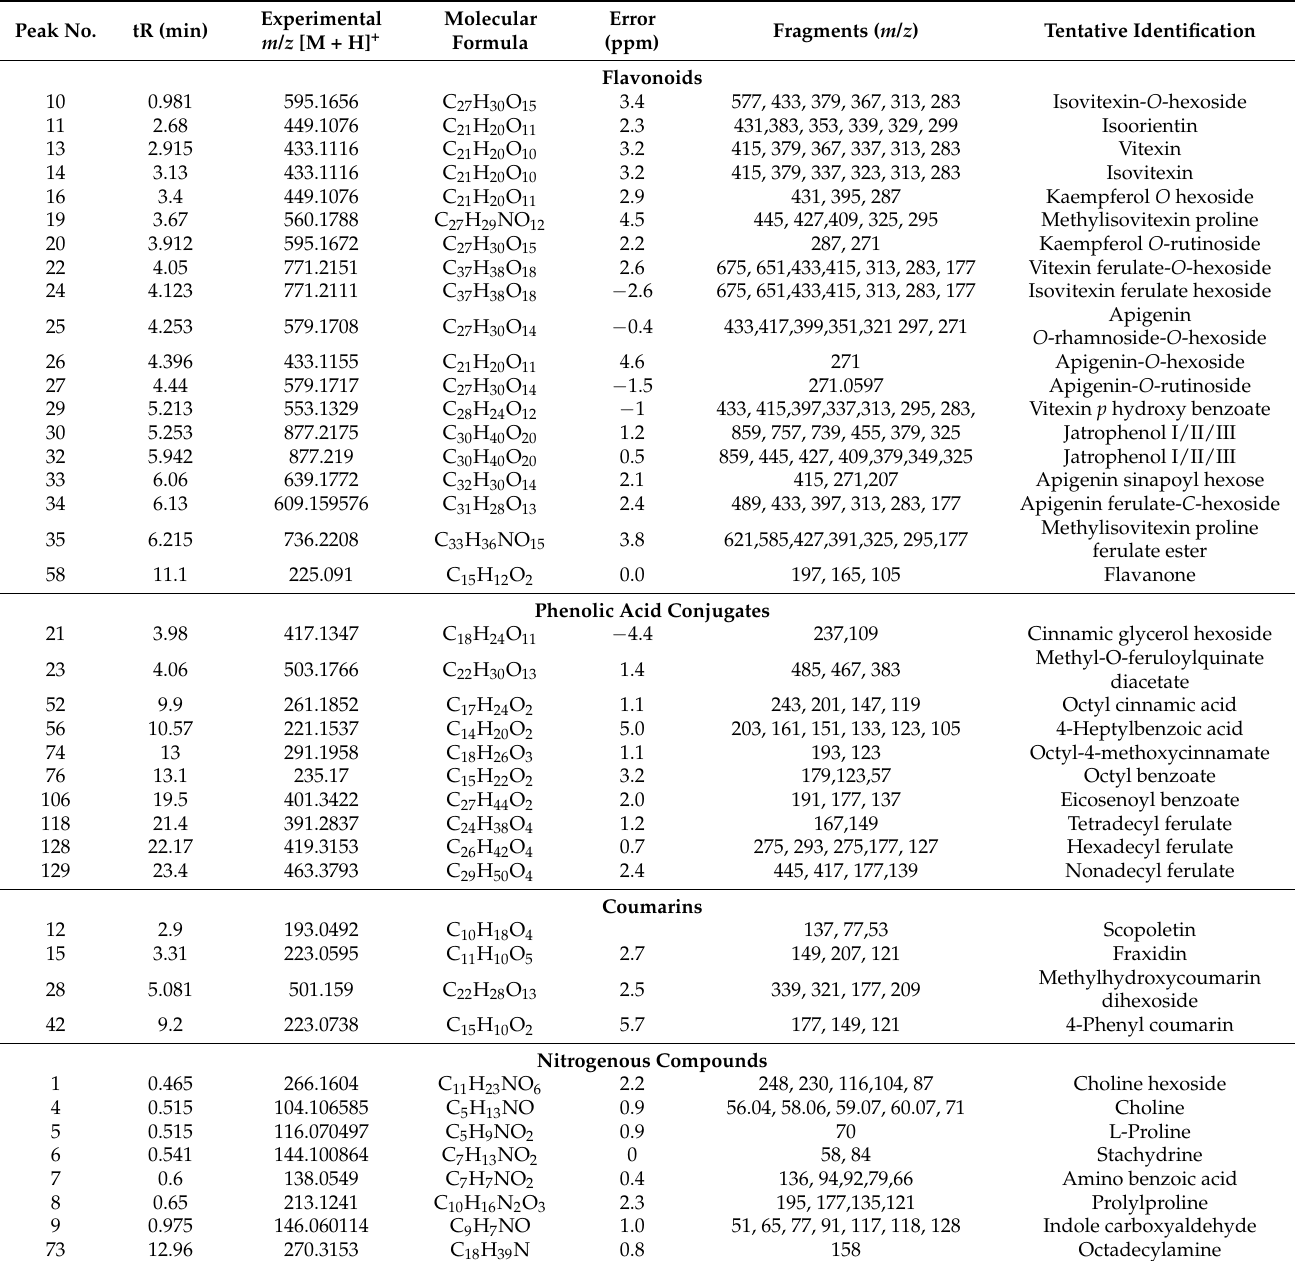
Table 3. Annotated metabolites in leaves extract of Jatropha integerrima using UPLC/MS-Q- TOF